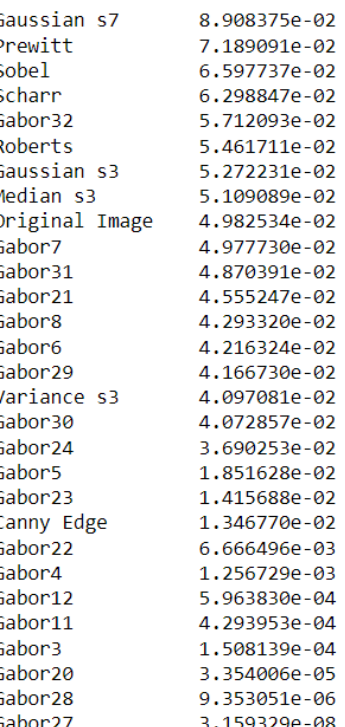
Figure A12. Image segmentation using the Otsu thresholding method.